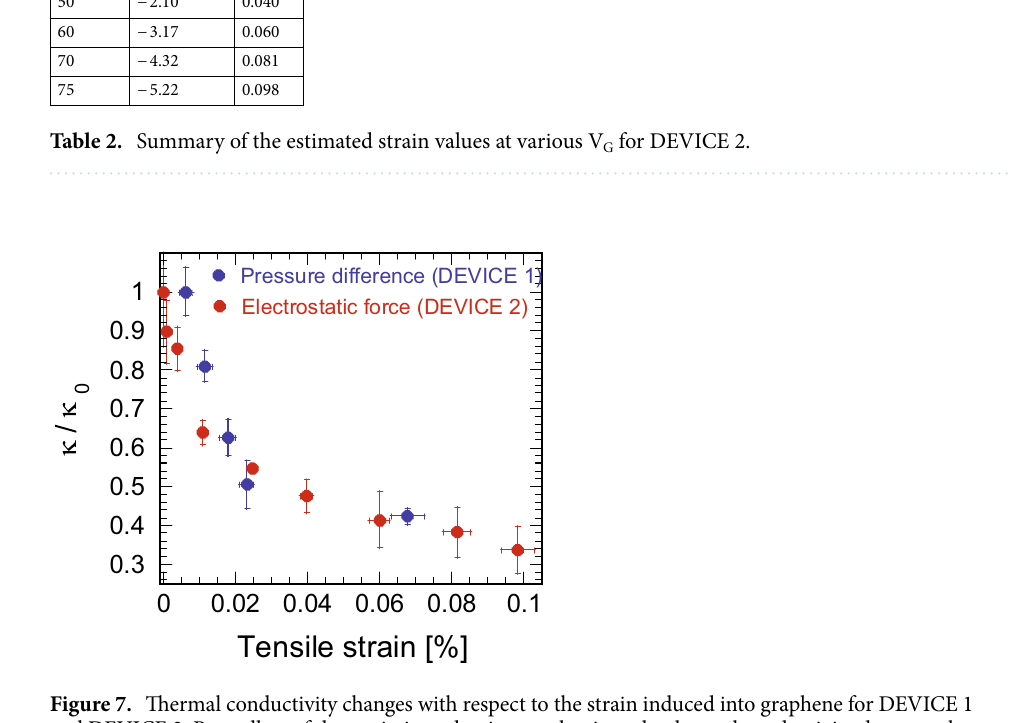
Figure 7. Thermal conductivity changes with respect to the strain induced into graphene for DEVICE 1 and DEVICE 2. Regardless of the strain introduction mechanism, the thermal conductivity decreases by approximately 60% with a strain of only